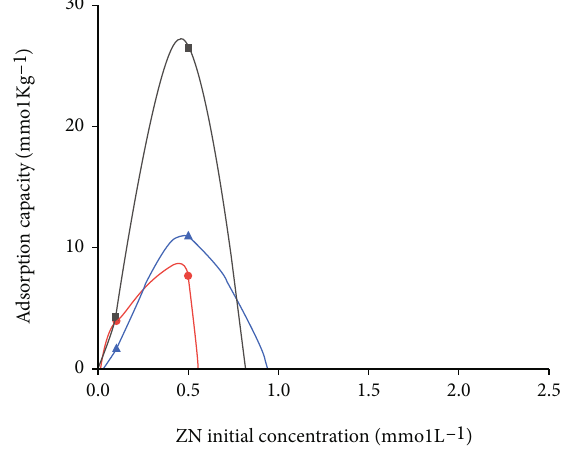
Figure 11: Adsorption of Zn 2+ in straw with di ff erent concentrations of heavy metal ions.